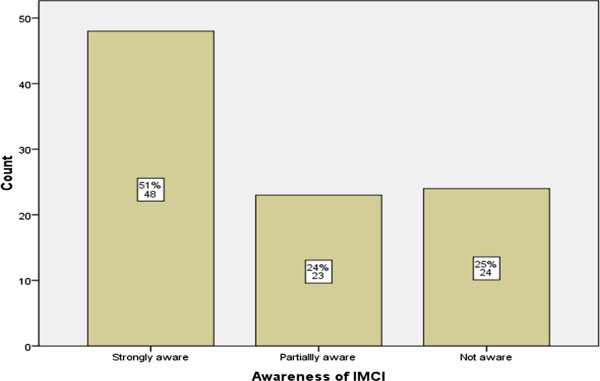
Awareness of IMCI.